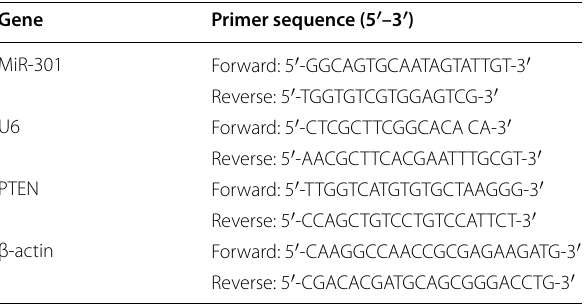
miR-301, MicroRNA-301; PTEN, phosphatase and tensin homologue